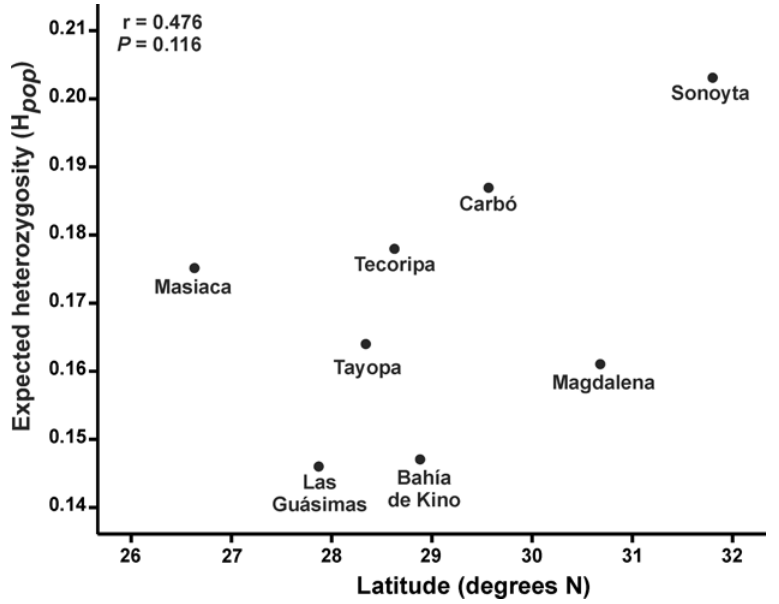
Fig 2. Relationship between average population heterozygosity ( H pop ) and latitude for eight populations of Stenocereus thurberi .